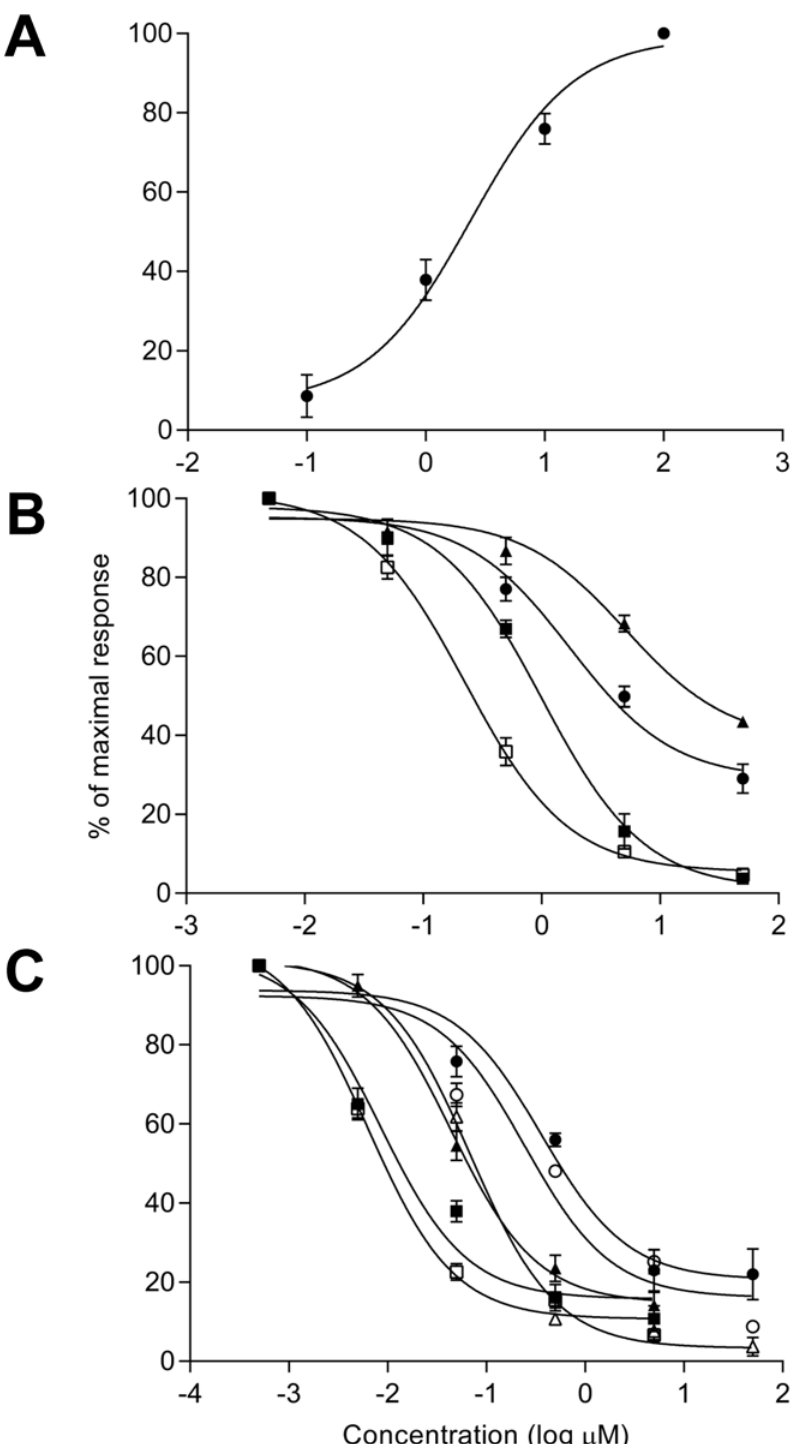
Fig 5. Effects of anticholinergic agents on NT2.N/A culture responses to the cholinergic agonist oxotremorine. A) Effect of perfusion of NT2.N/A cultures with oxotremorine for 1 min on release of Ca 2+ from astrocytic membrane bound stores; showing a sigmoidal log concentration-response curve for [Ca 2+ ] i increase in the NT2 astrocytes. B) Inhibition of the astrocytic response to the EC 50 concentration of oxotremorine by single anticholinergic drugs, Sigmoidal log concentration — response curves for inhibition of